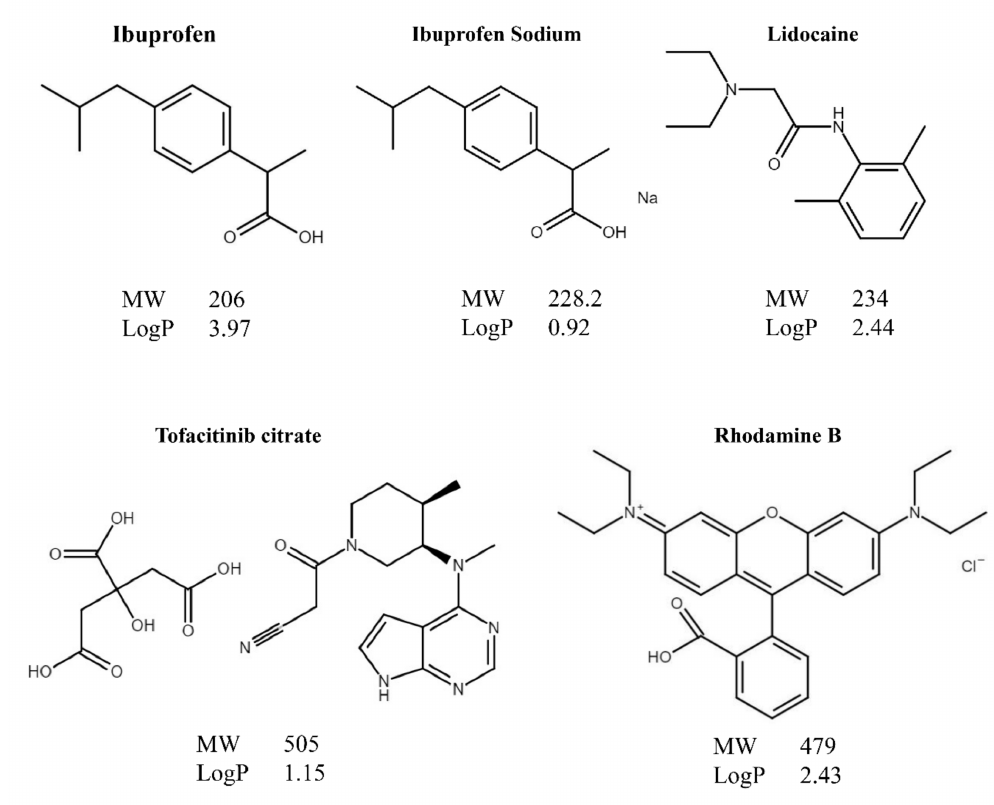
Figure 1. Chemical structure, molecular weight (MW) and logP of model drugs loaded into proposomes to study the skin